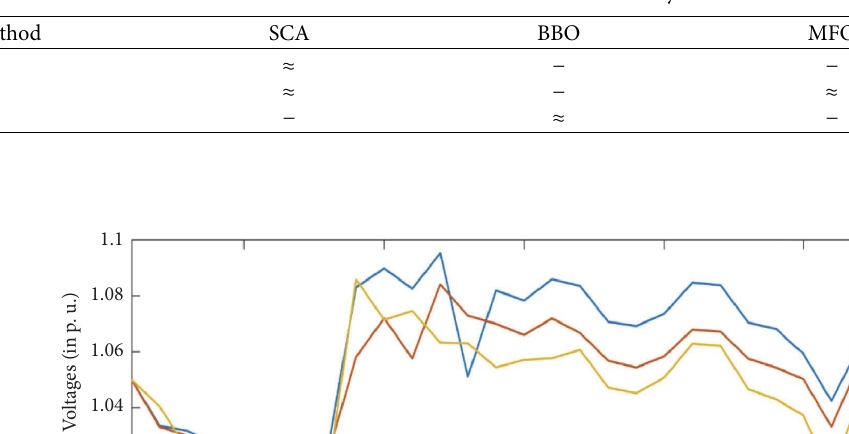
Table 6: WSRT results on IEEE 57 bus system.